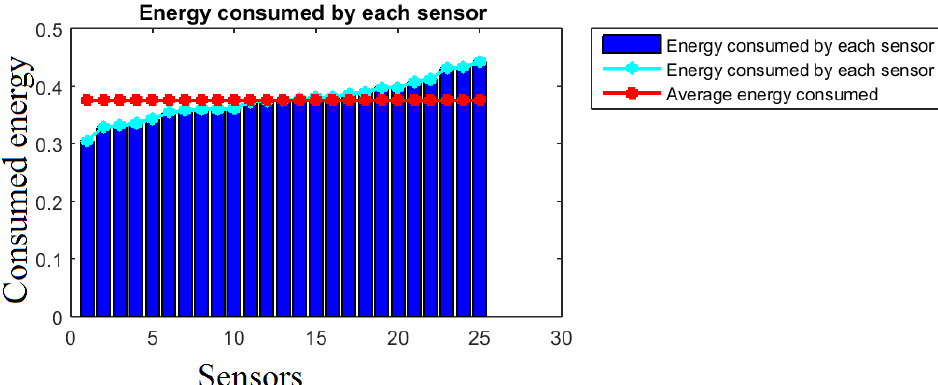
Figure 9. Energy consumed by each sensor for 50